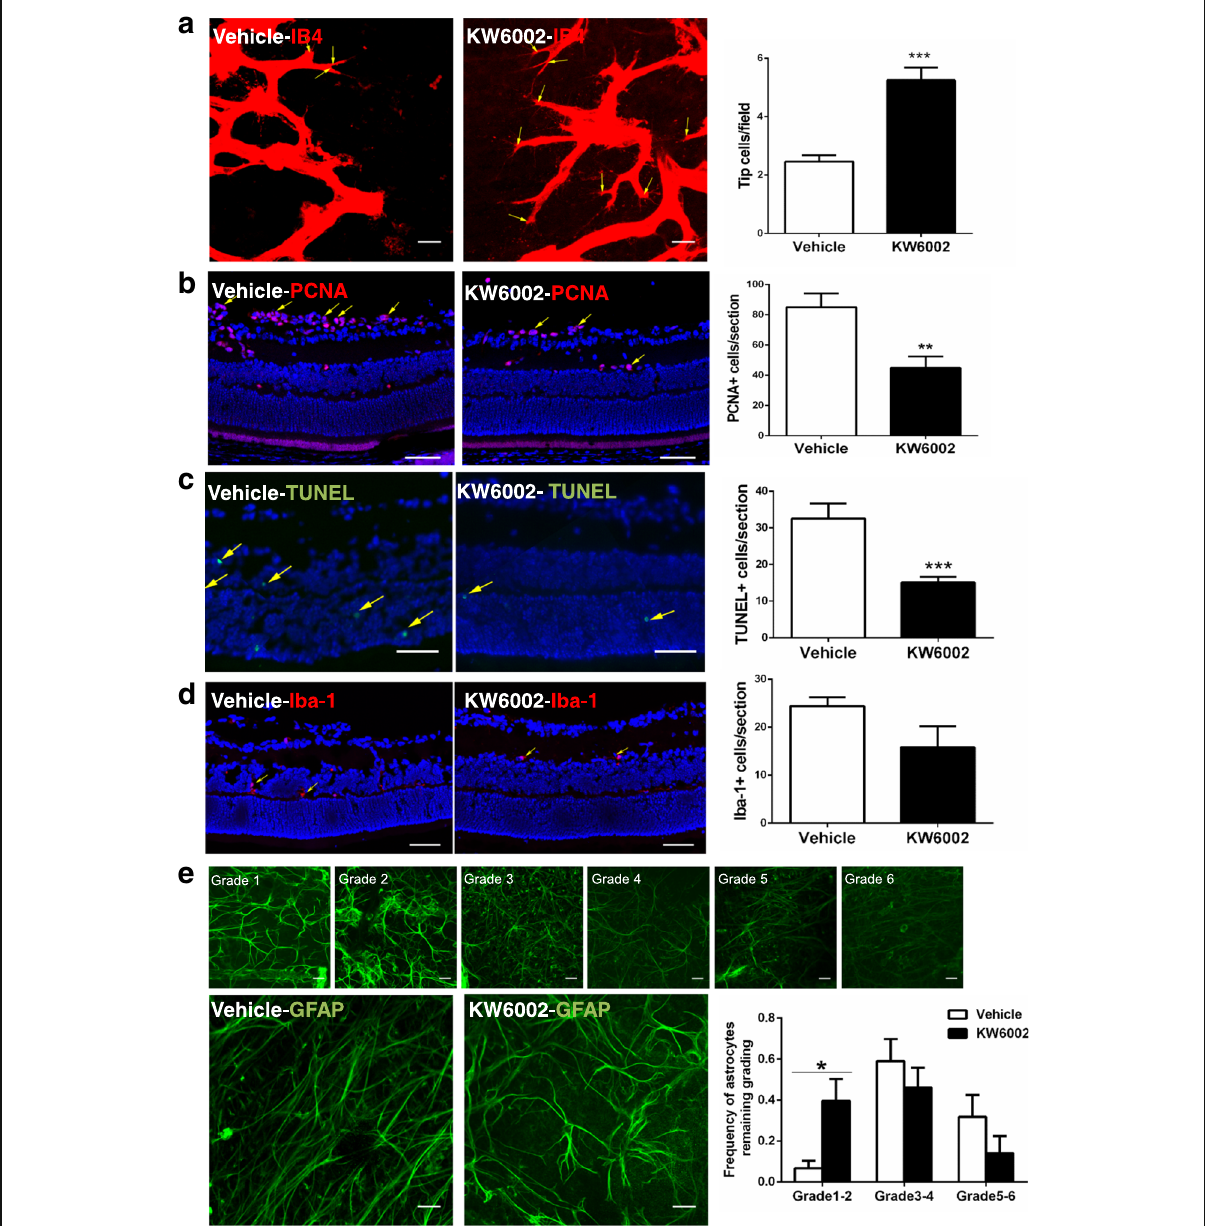
Fig. 3 In OIR, the effect of KW6002 treatment on cellular proliferation, tip cell, astrocytes and microglial numbers, and apoptosis in retina at P17. a Endothelial tip cells in retina at P17 of OIR were stained with isolectin B4 (red). Scale bar: 20 μ m. Quantitative analysis shows that KW6002 treatment increased tip cell number compared to the vehicle-treated pups (*** p <0.001, Student ’ s t-test, n =11 – 13/group). b Cell proliferation in retina was assessed by immunohistochemistry of PCNA at P17 of OIR. PCNA + cells (yellow arrow) were quantified. (** p <0.01, Student ’ s t-test, n =8/group). Scale bar: 50 μ m. c Apoptotic cells in retina were analyzed by TUNEL (green) staining and individual cells were visualized by DAPI (blue) staining at P17 of OIR. Retinal TUNEL-positive cells (yellow arrow) were quantified and analyzed. KW6002 treatment reduced cellular apoptosis in (** p <0.01, Mann- Whitney U test, n =8 – 9/group). Scale bar: 50 μ m. d Microglial activation in retinas was assessed by immunofluorescence staining of Iba-1 at P17 of OIR. Retinal Iba-1-positive cells (yellow arrow) were quantified and analyzed. ( p >0.01, Student ’ s t-test, n =8/group). Scale bar: 50 μ m. e Representative images show GFAP-positive cells in the avascular areas by anti-GFAP (green) staining at P17 of OIR. Scale bar: 20 μ m. GFAP staining in the avascular area was graded on a scale from 1 to 6 as described in the Methods section. The grades of astrocytes from each treatment group were analyzed at P17 of OIR. KW6002 treatment enhanced GFAP staining (with the reduced grade) (* p <0.05, Mann-Whitney U test, n =9 – 12/group), Scale bar: 20 μ